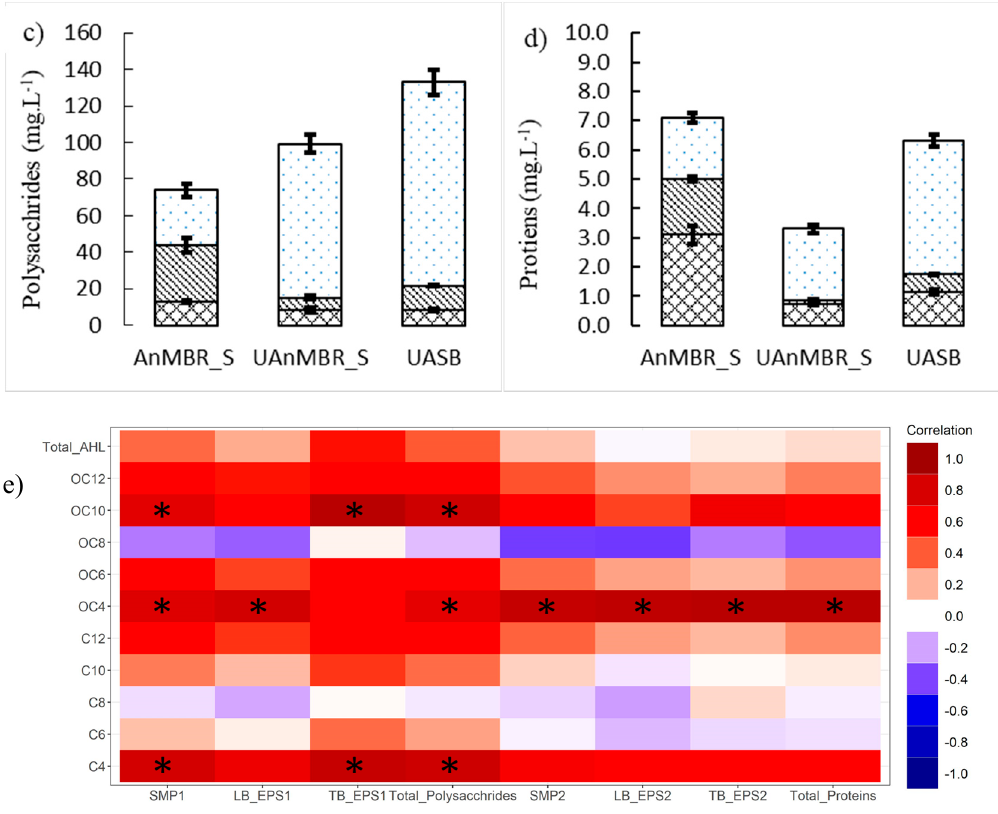
Figure 3. ( a ) Polysaccharides in soluble extracellular polymeric substance (S_EPS), loosely bound extracellular polymeric substance (LB_EPS), and tightly bound extracellular polymeric substance (TB_EPS) in AnMBR_BF and UAnMBR_BF; ( b ) proteins in S_EPS, LB_EPS, and TB_EPS in AnMBR_BF and UAnMBR_BF; ( c ) polysaccharides in S-EPS, LB-EPS, and TB-EPS in AnMBR_S, UAnMBR_S, and UASB; ( d ) proteins in S_EPS, LB_EPS, and TB_EPS in AnMBR_S, UAnMBR_S, and UASB. The concentrations of the proteins and polysaccharides in the biofilms are reported in mg kg − 1 , while in the sludge, they are reported in mg L − 1 (error bars represent standard deviation of replicates; n = 2). ( e ) Pearson correlation between proteins, polysaccharides, and AHL present in the biofilm and sludge of the AnMBR, UAnMBR, and UASB. S_EPS1: polysaccharides in soluble extracellular polymeric substances; LB.EPS1: polysaccharides in loosely bound extracellular polymeric substances; TB.EPS1: polysaccharides in tightly bound extracellular polymeric substances; S.EPS2: proteins in soluble extracellular polymeric substances; LB.EPS2: proteins in loosely bound extracellular polymeric substances; TB.EPS2: proteins in tightly bound extracellular polymeric substances. The asterisk